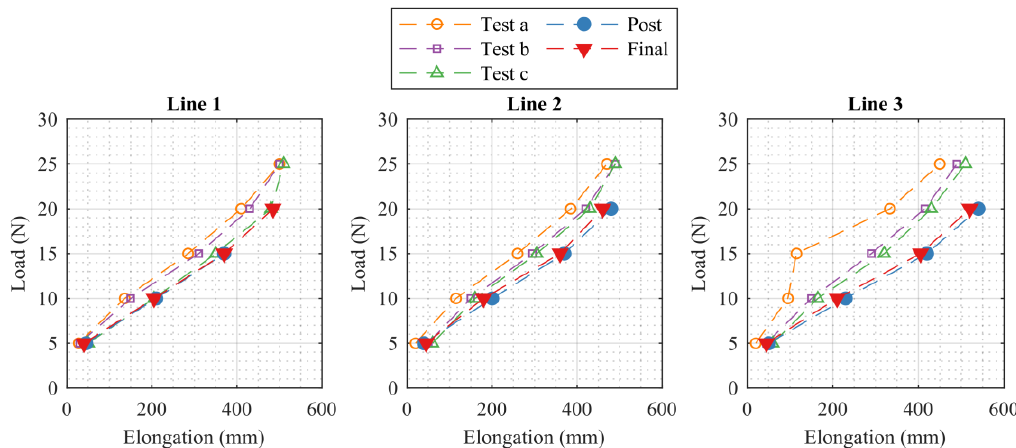
Figure 8. Load-elongation curve for the three lines used in the experimental mooring system.